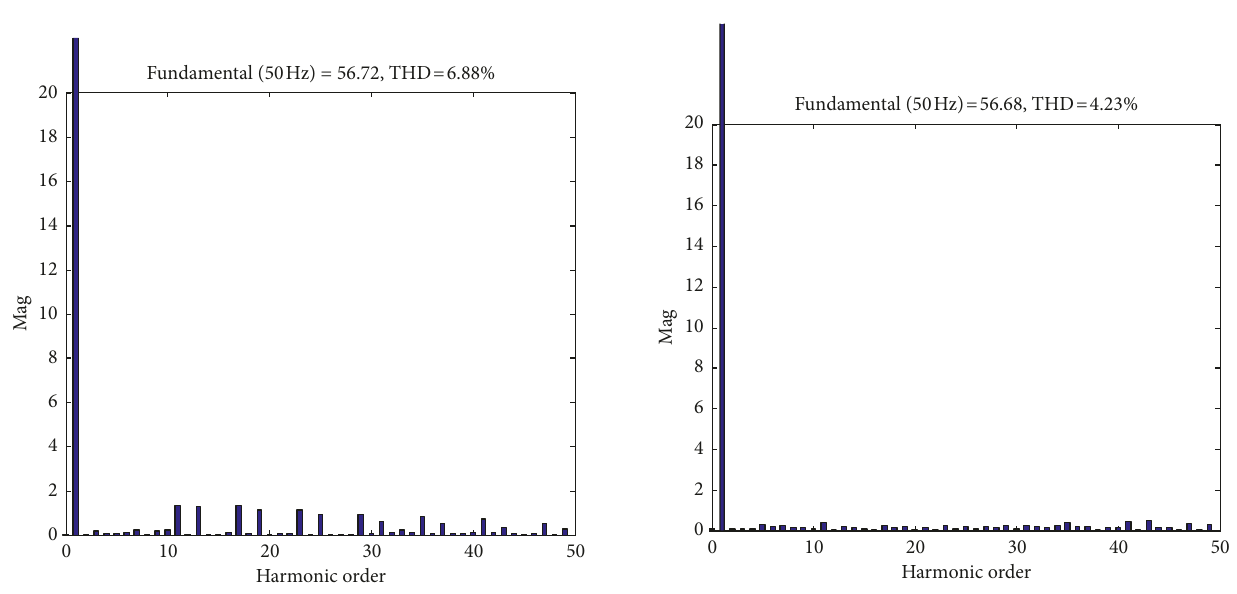
Figure 16: FFT analysis of nonlinear load current using PI con- troller and 6th VR controller.